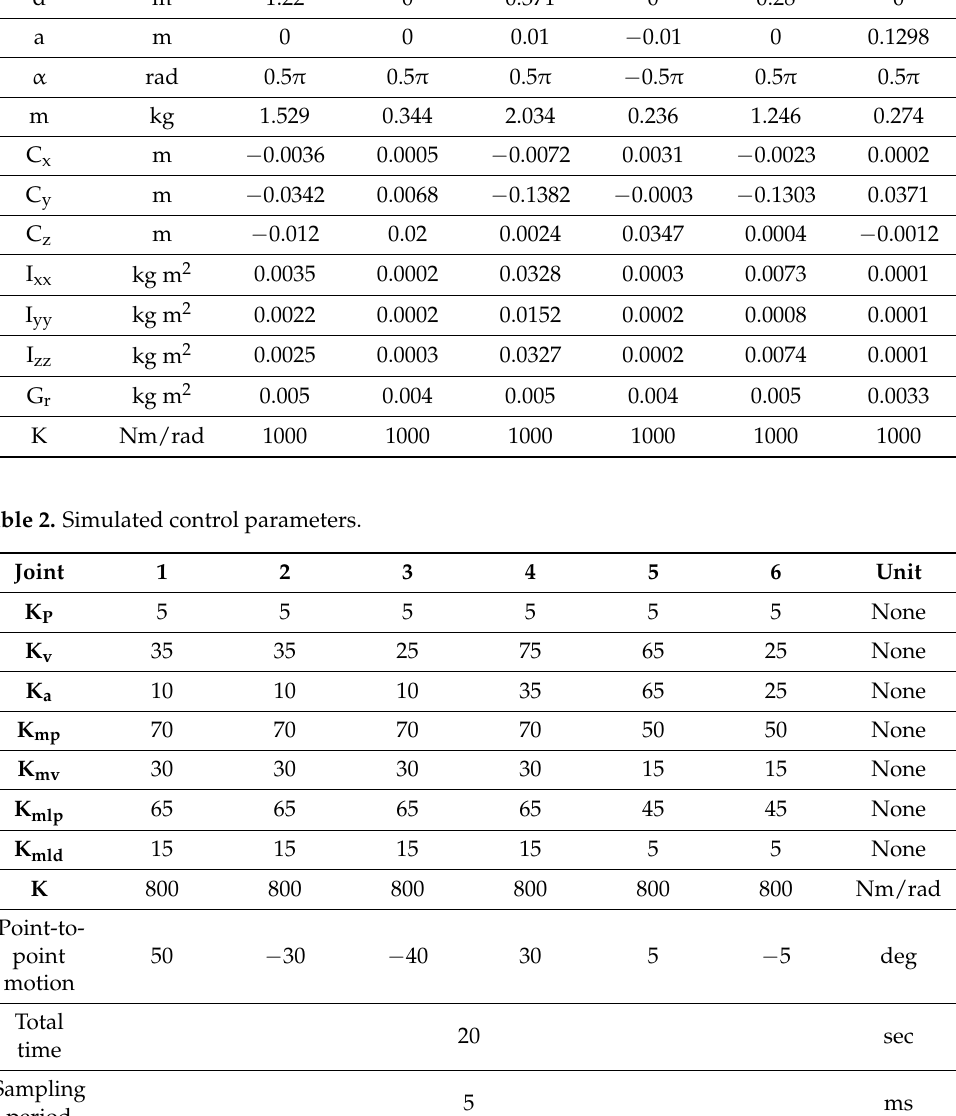
error, as shown in Figure 5. The solid line is the output of the link side, and the dotted line is the output of the motor side. Figure 5 shows the simulation results of applying the elastic-joint feedback controller to manipulate a 6-DOF robotic arm on the desired trajectory. The vibration caused by the structure at the endpoint causes a position